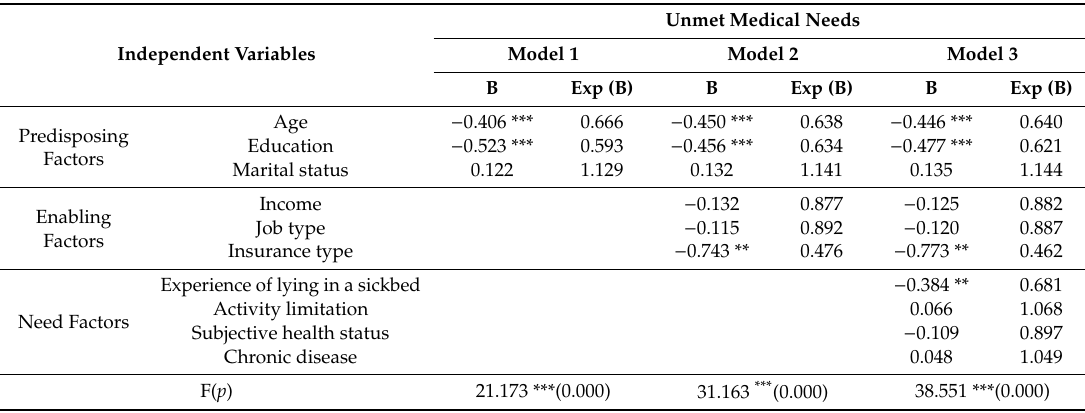
Table 3. Factors a ff ecting unmet medical